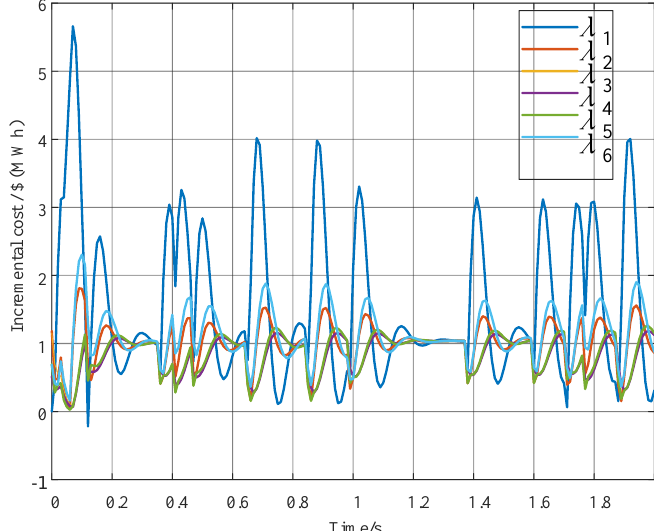
Figure 4. Response using the control strategy of [4] at p = 0.9.